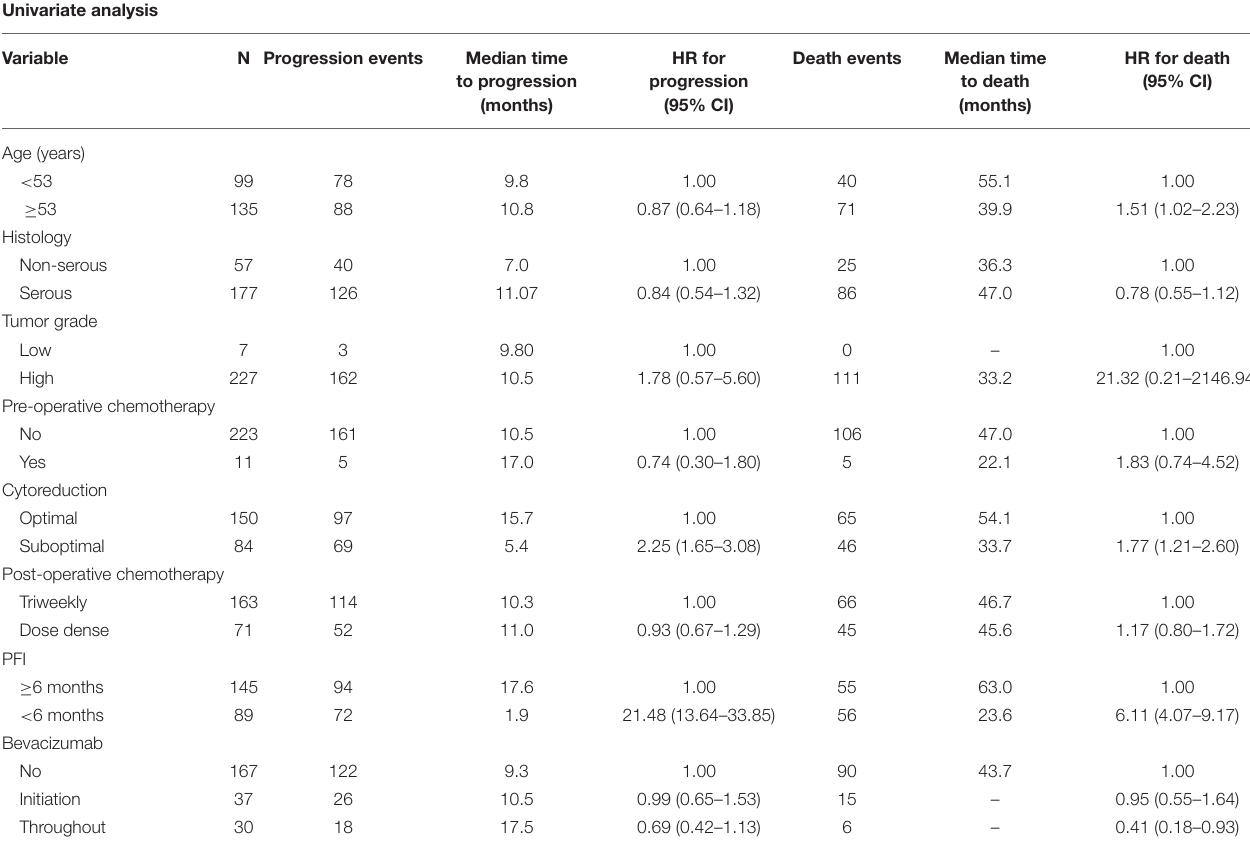
TABLE 3 | Univariate analysis in newly diagnosed cancer patients with stage III and IV disease ( n = 234). Univariate analysis